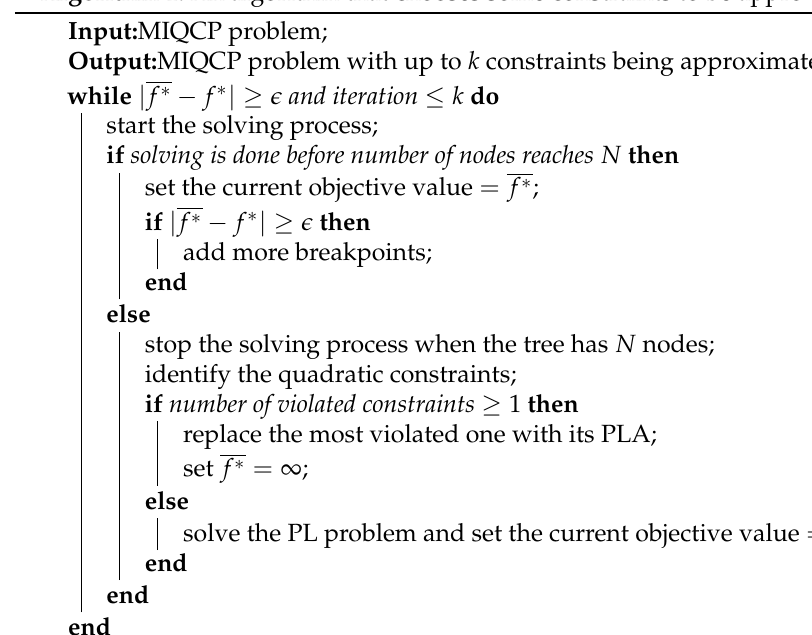
Algorithm 1: An algorithm that chooses some constraints to be